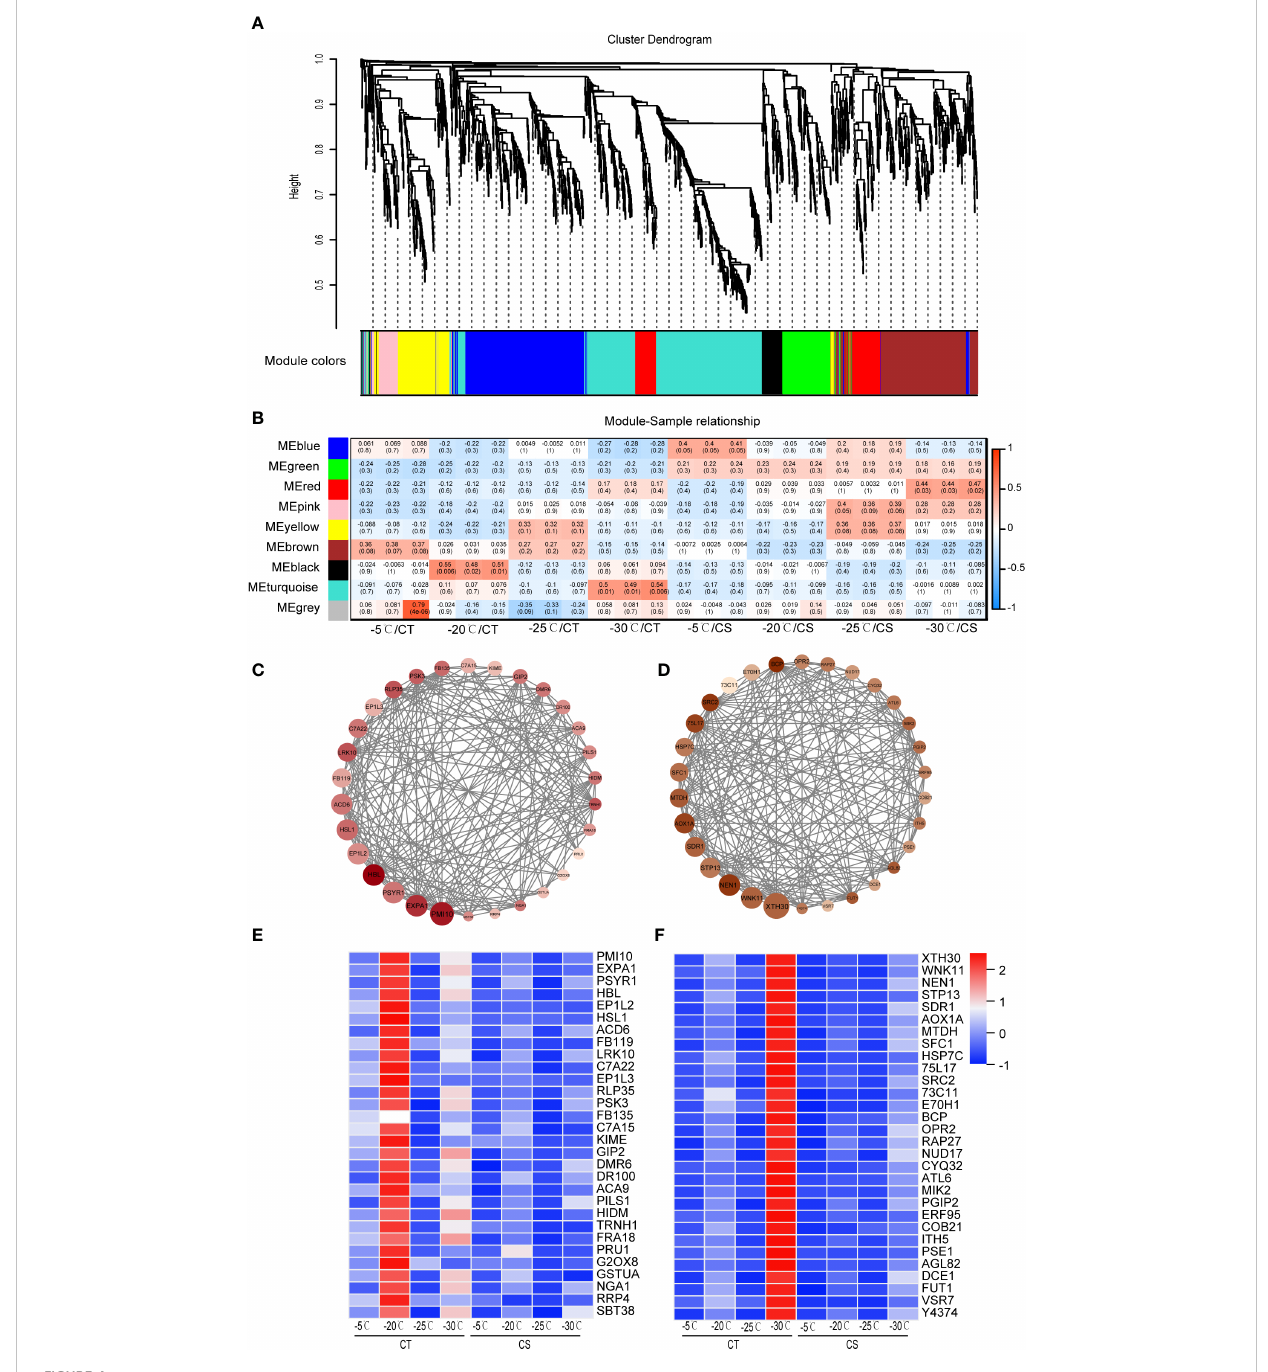
FIGURE 4 WGCNA identi fi es key modules of hub genes of peach in response to cold. (A) Hierarchical cluster tree showed 9 modules of co-expressed genes in peach under cold stress. (B) Heat map of correlations between metabolites and gene modules. Values in each cell represent the coef fi cient value of correlation (upper) and the p-values (lower in parentheses) of the module-trait association. (C) Protein-protein interaction network of co-expressed genes from the black module. (D) Protein-protein interaction network of co-expressed genes from the turquoise module. (E) Expression heat map of genes in the black module. (F) Expression heat map of genes in the turquoise module. Scaled values were used to present the FPKM of genes in the heat